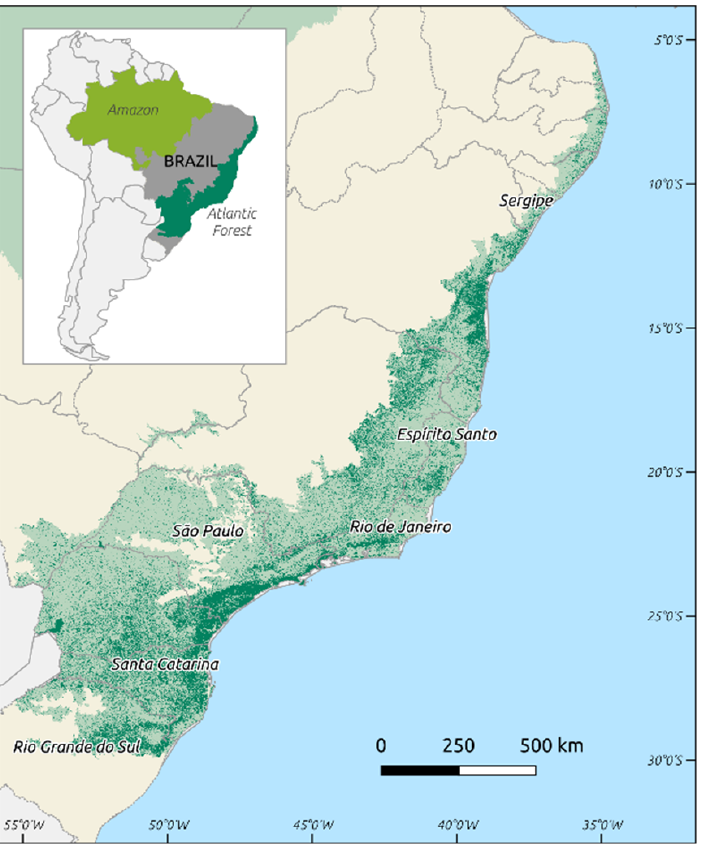
Figure 1. Map of Brazil, with the Brazilian Amazon in light green and the Brazilian Atlantic Forest in dark green: darker areas in the Atlantic Forest correspond to remaining forest fragments [7]. Bromeliad-malaria is transmitted in the Atlantic Forest system by mosquitoes of the Kerteszia subgenus, with Anopheles (Kerteszia) cruzii being the most abundant [8–12]. Infections can occur in hosts that are blood meal sources for the mosquitoes generally located on the top of trees because of the acrodendrophilic behavior of these insects (the tendency of certain wild species to live and preferentially feed in the canopy). When these mosquitoes come down to lower heights, they feed on non-usual hosts such as humans. The acroden- drophilic behavior of An. (K.) cruzii is well documented, but several studies have shown that this species may also occur in high densities at ground level in the forest, including infected specimens [13,14]. The transmission cycle in this region does not fit the traditional malaria cycle, as cases occur at large distances from each other and are often separated by several weeks. The exis- tence of a zoonosis, with infected simians participating in the epidemiology, is hypothesized (Figure 2). Despite Plasmodium simium and Plasmodium brasilianum being implicated as the etiologic agents of simian infections, several studies have suggested that P. vivax and P. malariae are the same species as P. simium and P. brasilianum , respectively, based on their genetic and morphological similarities